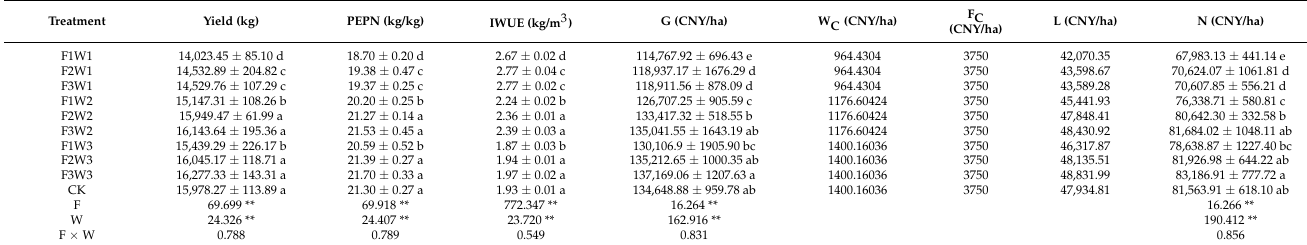
Table 7. Effects of the method and volume of irrigation on yield, partial nitrogen fertilizer productivity (PEP N ), irrigation water-use efficiency (IWUE), and Net Profits in pear.